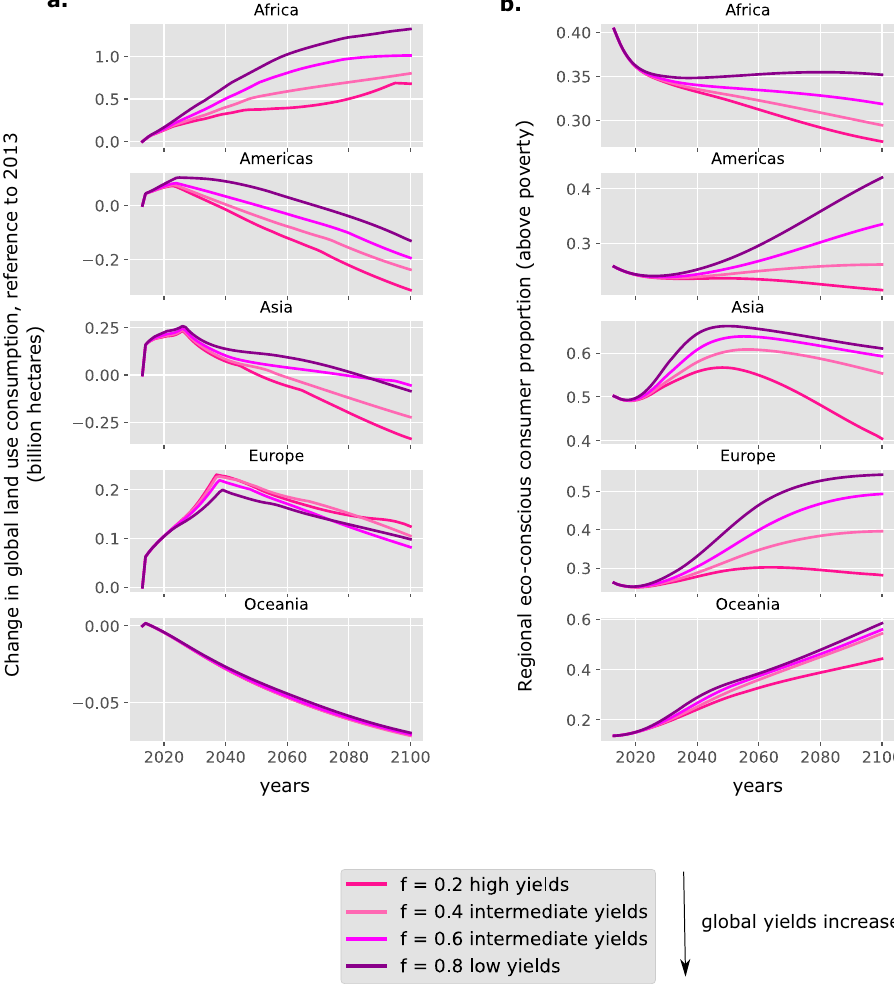
Fig. 3 Baseline country-level projections when aggregated into fi ve continental groups reveal distinct behavioral patterns of consumption. Country- level projections for global land-use change with respect to 2013 and corresponding eco-conscious consumer proportion till 2100 are aggregated into fi ve continental groups. We use fi ve continent groups to classify the 153 countries in our projection analysis (see Supplementary Data 1). Results are shown for yield scenarios ranging from high ( f = 0.2) to low ( f = 0.8) future yields at the SSP2 income and population scenario. Projections for the regional breakdown of global land-use change are shown in panel ( a ). Projections for corresponding eco-conscious consumer proportions in respective regions are shown in panel ( b ). For regional projections under all SSP scenarios at high ( f = 0.2) and low ( f = 0.8) future yields scenarios, see Supplementary Fig.